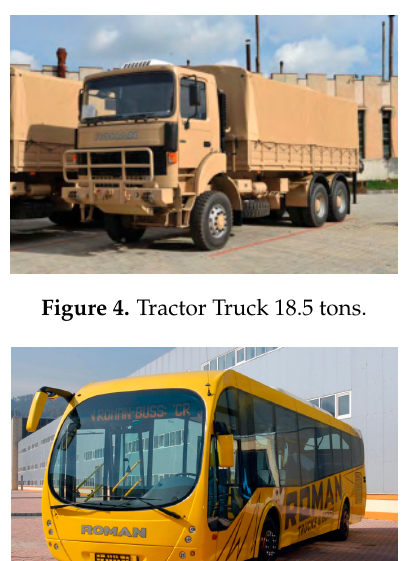
Figure 3. Graphical representation of the application of the new eco-friendly method at the Roman SA Company.